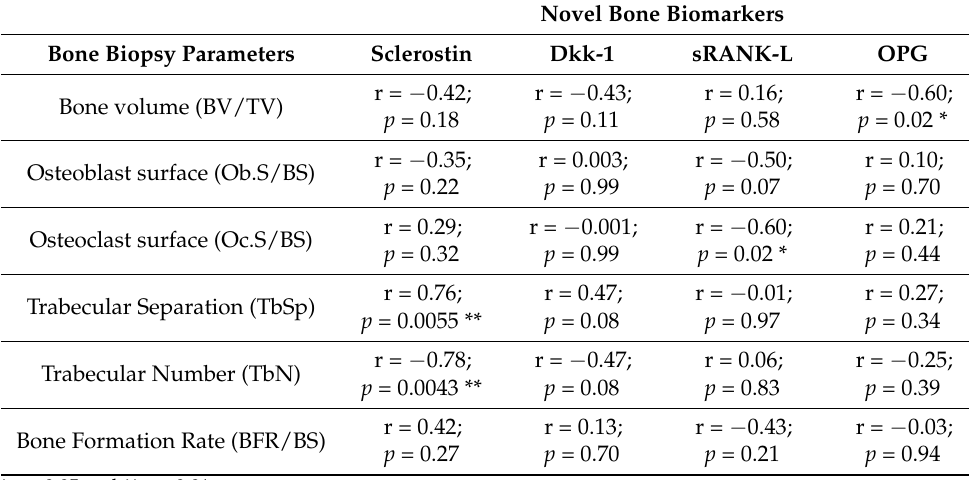
Table 3. Correlation between novel bone biomarkers and bone biopsy parameters.